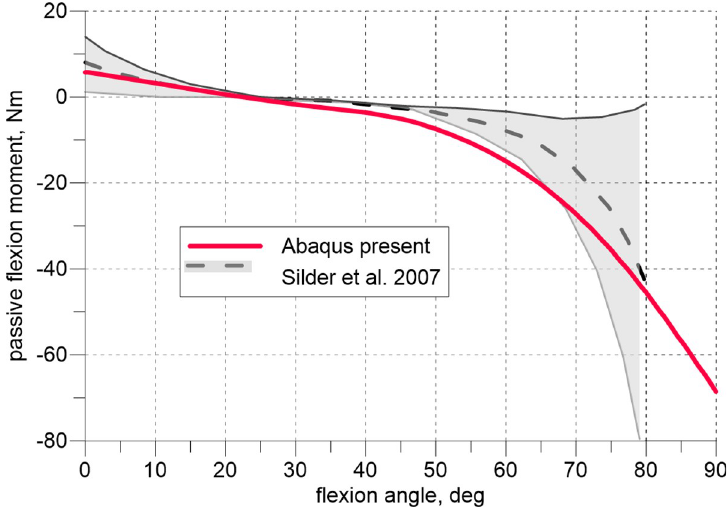
Fig 4. Passive hip flexion moment vs. flexion angle; 15˚ knee